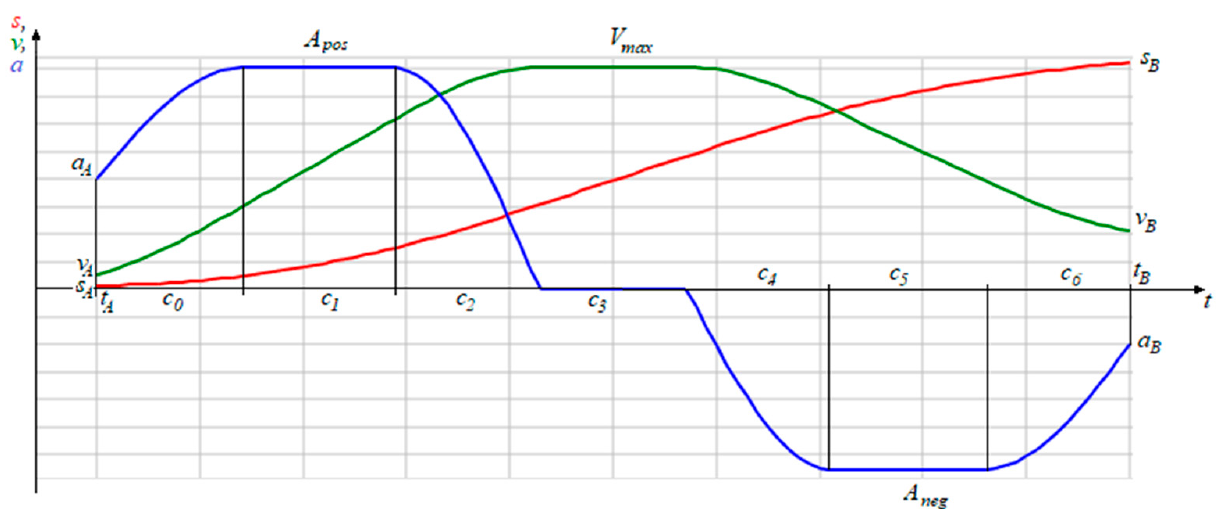
Figure 2. Modified seven traits motion law, with imposed constraint values on displacement and velocity.